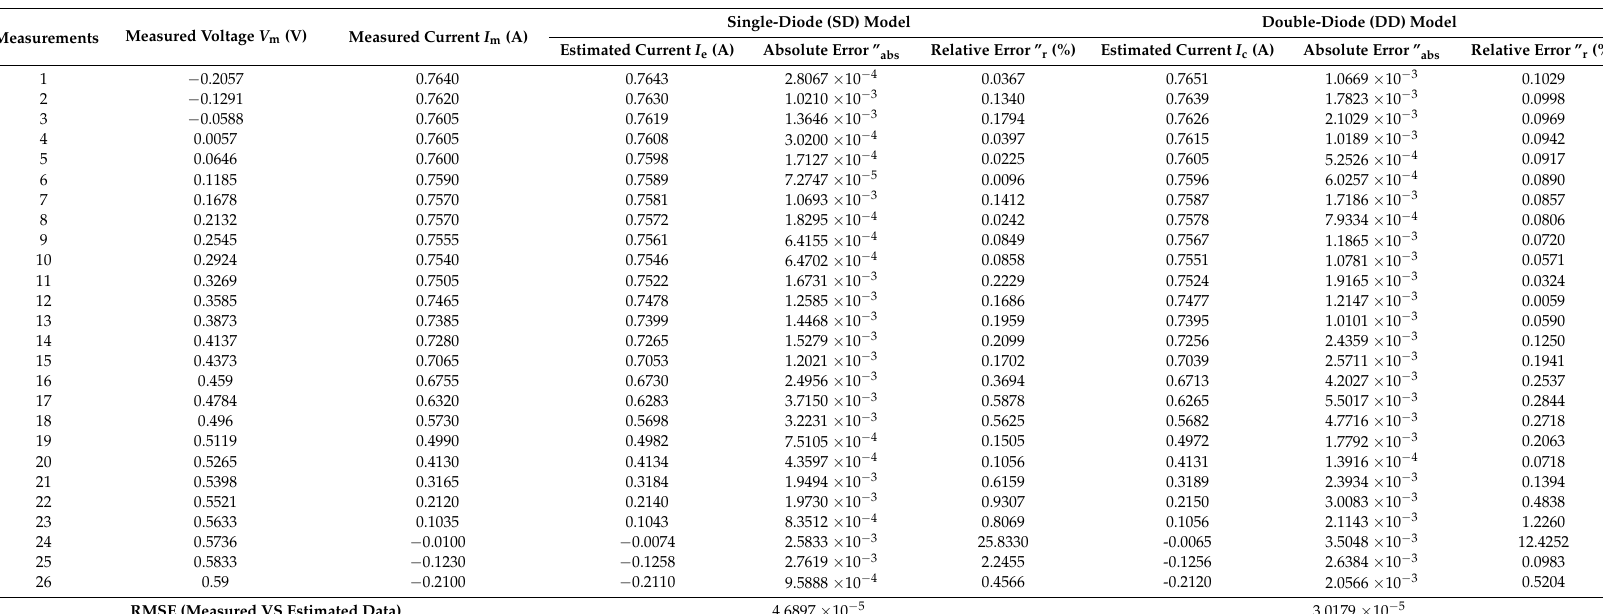
Table 2. CGSA-6 absolute and relative error values for the SD and DD models with regard to the extracted PV cell I-V measurements at specific test conditions ( G = 1000 W/m 2 and T c = 33 ◦ C